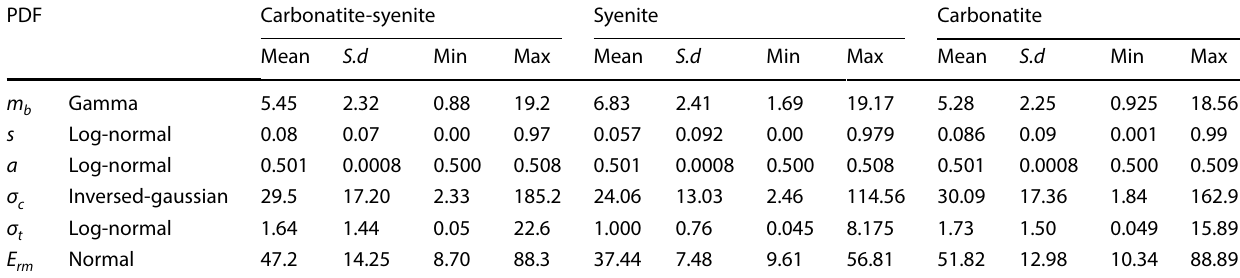
Table 11 The mean values and standard deviations of geomechanical parameters for the syenite, carbonatite and carbonatite-syenite rock mass PDF Carbonatite-syenite Syenite